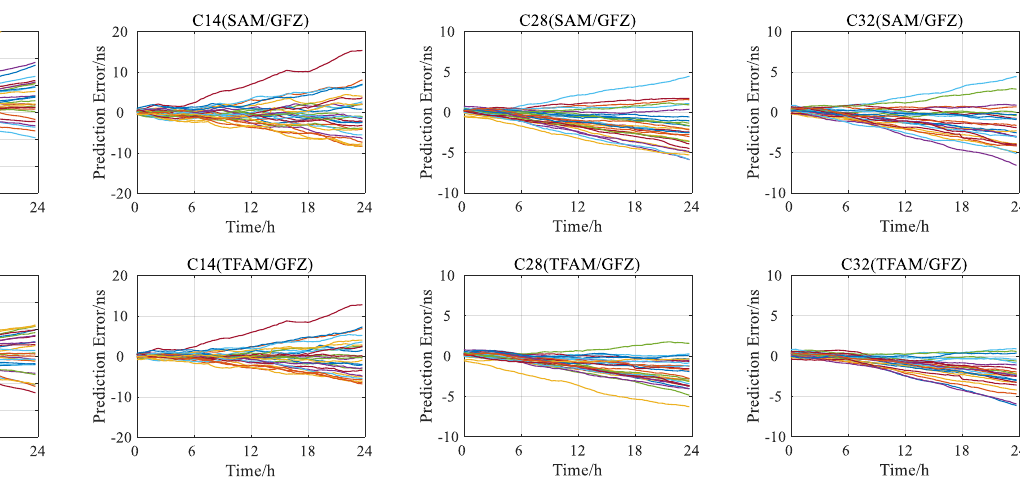
Figure 13. Prediction errors of WHU clock offsets for 30-day.